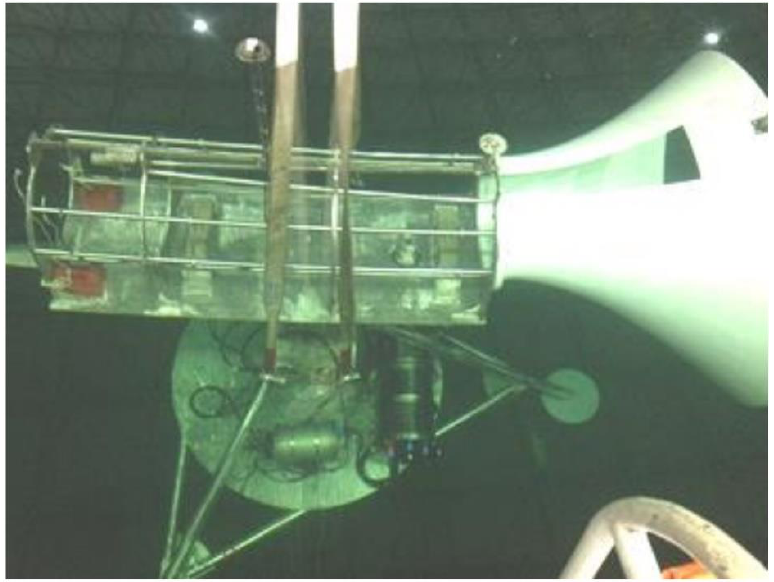
Figure 13. Physical experiment diagram of the docking device in the water pool.